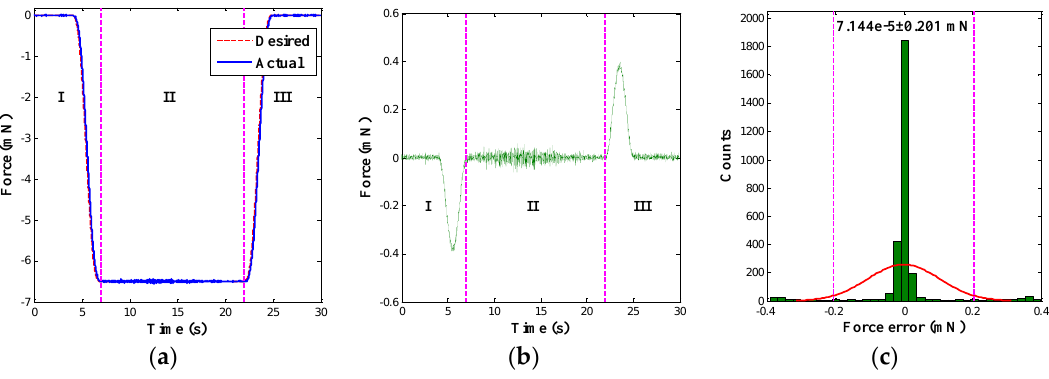
Figure 11. Force control results of a cycloid trajectory. ( a ) Force tracking result; ( b ) Force tracking error; and ( c ) Histogram of force tracking error.